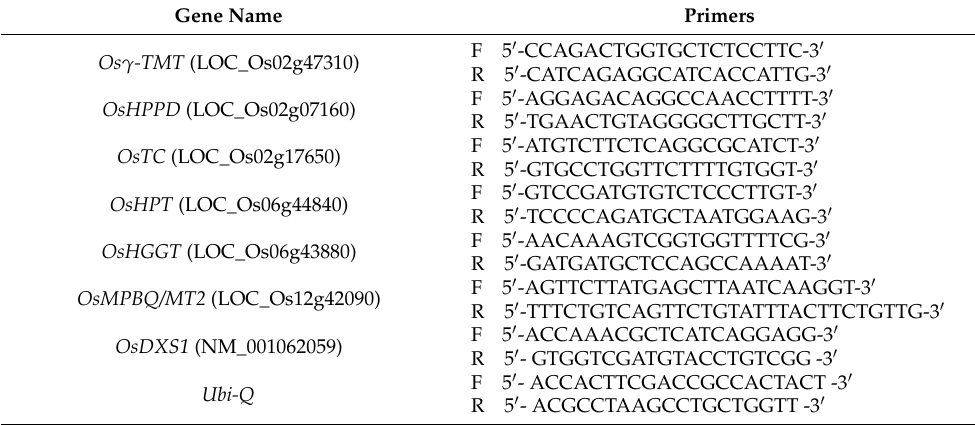
Table 1. The nucleotide sequences primers of vitamin E synthesis-related